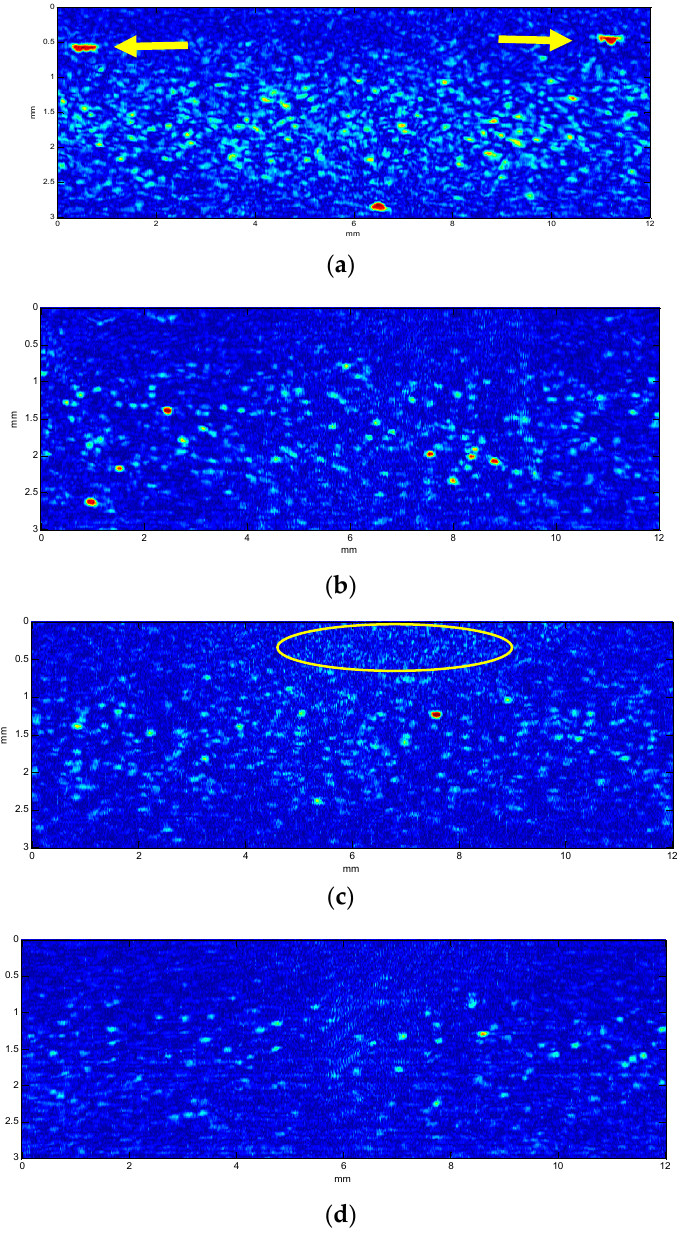
Figure 4. Ultrasound images obtained at 20 MHz for lymphocytes 696 cells/ µ L ( a ) and 140 cells/ µ L ( b ), and granulocytes at 165 cells/ µ L ( c ) and 41 cells/ µ L ( d ). The yellow arrows in ( a ) point to sample impurities and the circle in ( c ) shows mechanical noise produced by coupling problems between the emitter and the tube sample covered by the polyethylene film. Considering that diameters of both lymphocytes and granulocytes are significantly lower than the wavelength used in this work (75 µ m), it was expected that no